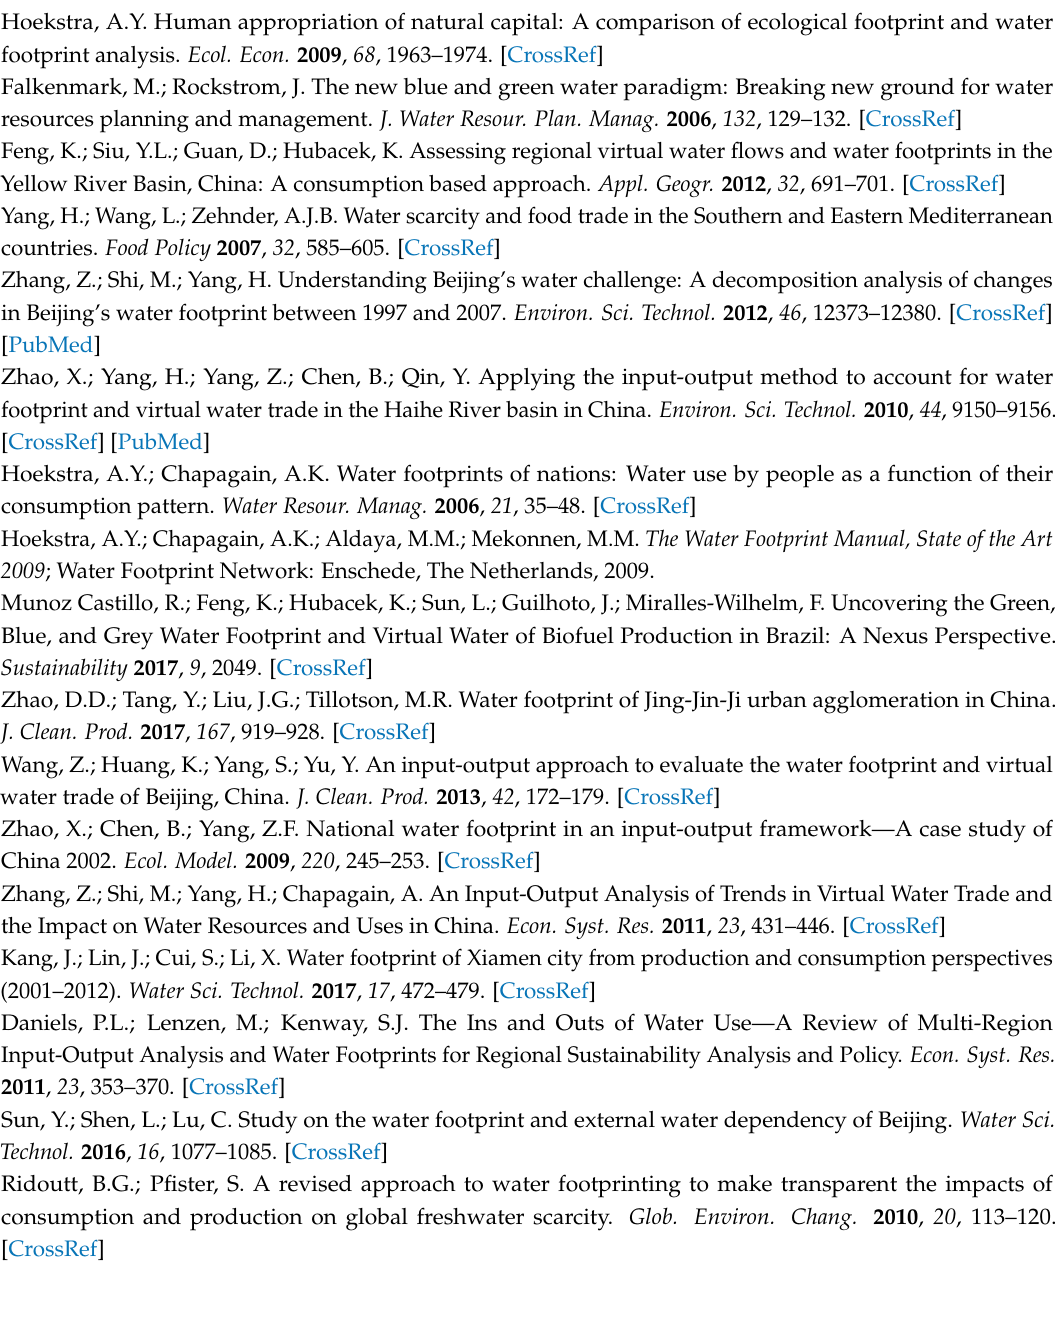
Table S1: COD emissions in secondary industrial sectors from 2002 to 2012; Table S2: NH3-N emissions in secondary industrial sectors from 2002 to 2012; Table S3: Quantity of nitrogen fertilizer; Table S4: Water use and return water in industrial sectors; Table S5: Water use, water consumption and return